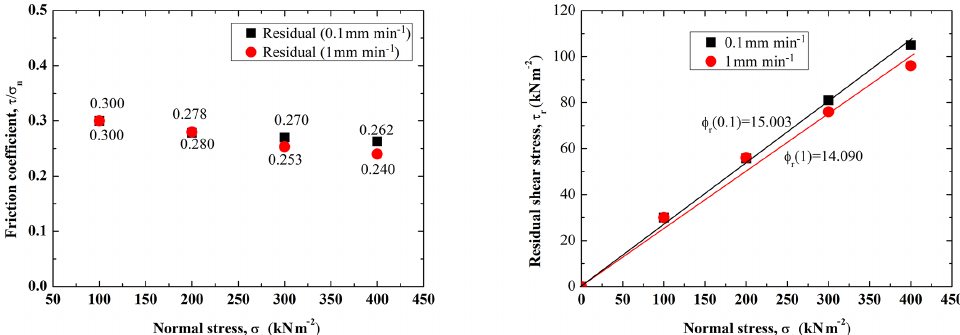
Figure 8. Relationships between residual shear stress and normal stress, and residual strength parameter for DJG soil sample.